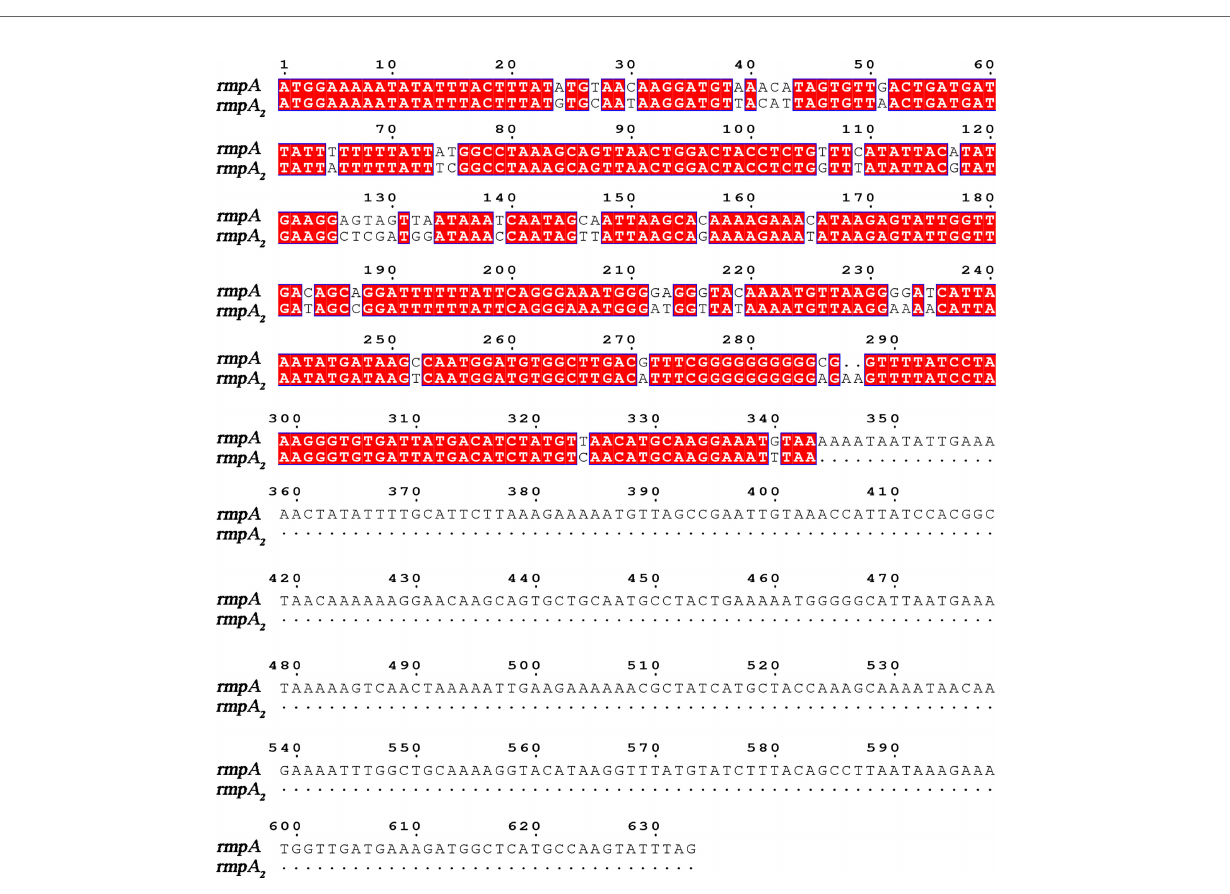
FIGURE 1 | Sequence alignment of rmpA2 and rmpA